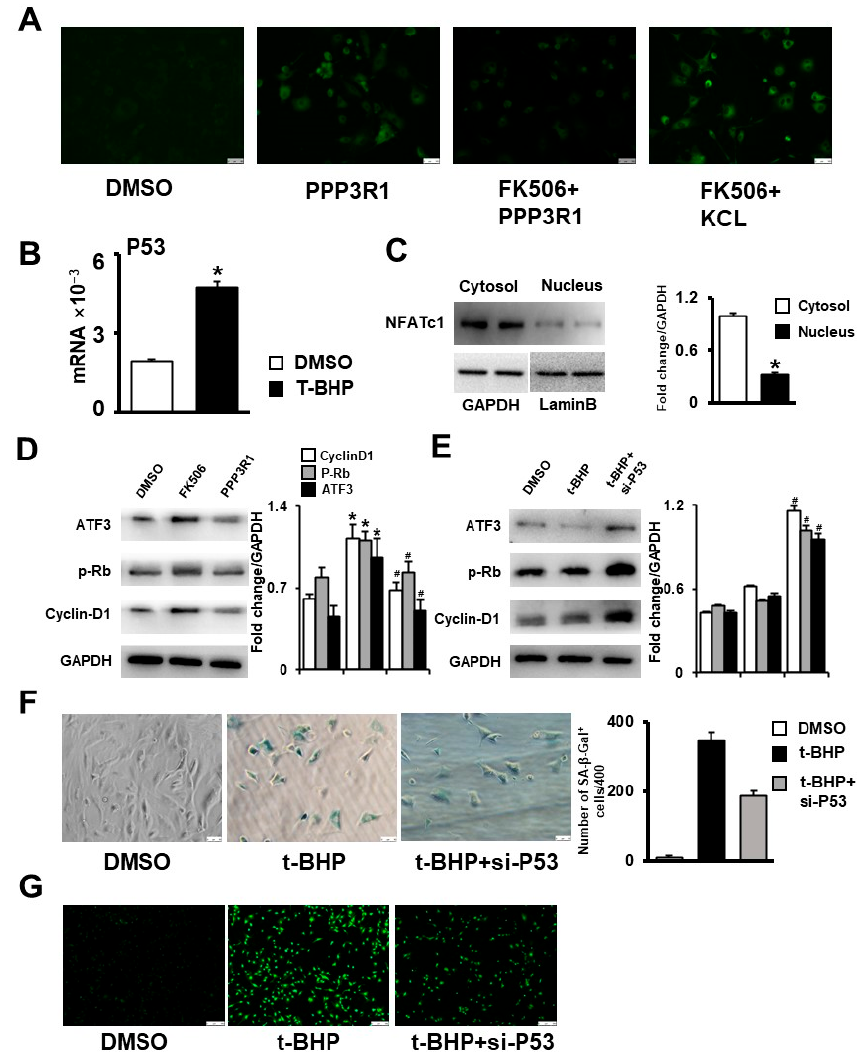
Figure 5. Plasma membrane depolarization increases Ca 2+ influx and activates NFAT/ATF3/p53 signaling, thereby inducing MSC senescence. After the cells were treated with PPP3R1 recombinant protein, FK506 and forced depolarization agent KCL, the changes of calcium ions in the cells were detected by ( A ) calcium ion fluorescent probe, and the expression of P53 in senescent cells was detected by ( B ) qPCR. ( C ) WB was used to detect the protein expression of NFATc1 in the cytoplasm and nucleus of senescent cells. ( D , E ) WB was used to detect the protein expression of ATF3, p-Rb, and Cyclin-D1 in different groups. ( F ) β -galactosidase staining was used to detect cell senescence after interfering with P53 expression. ( G ) ROS staining was used to detect the changes of reactive oxygen species after interfering with P53 expression. * # p < 0.05 (Scale bars: ( A ) 100 μ m, ( F ) 50 μ m, ( G ) 250 µ